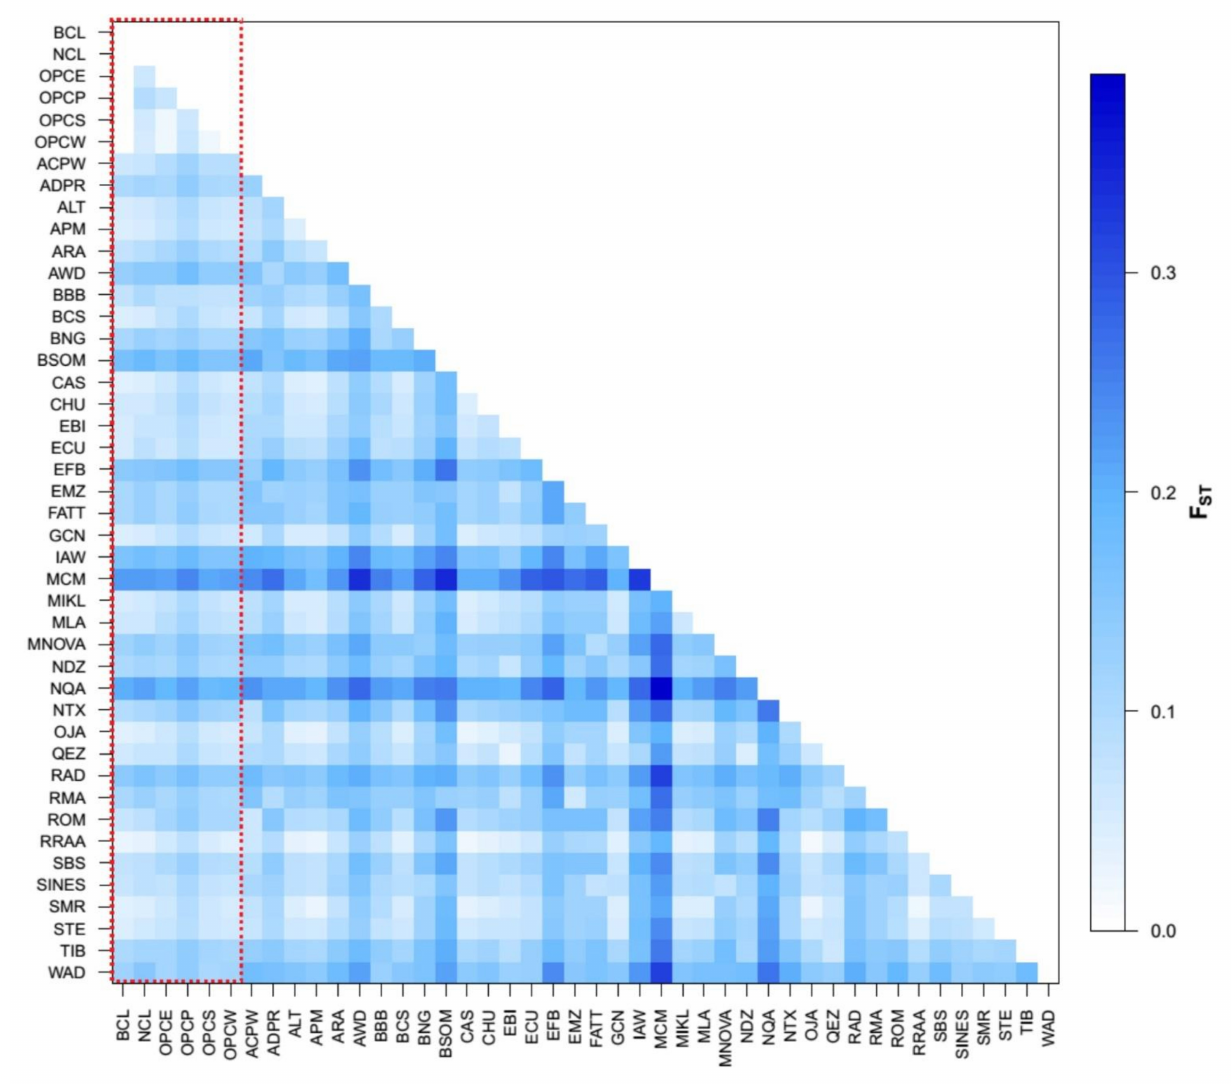
Figure 2. Genetic differentiation pairwise FST Matrix values among 44 sheep populations/breed. the dashed red line highlights the Colombian